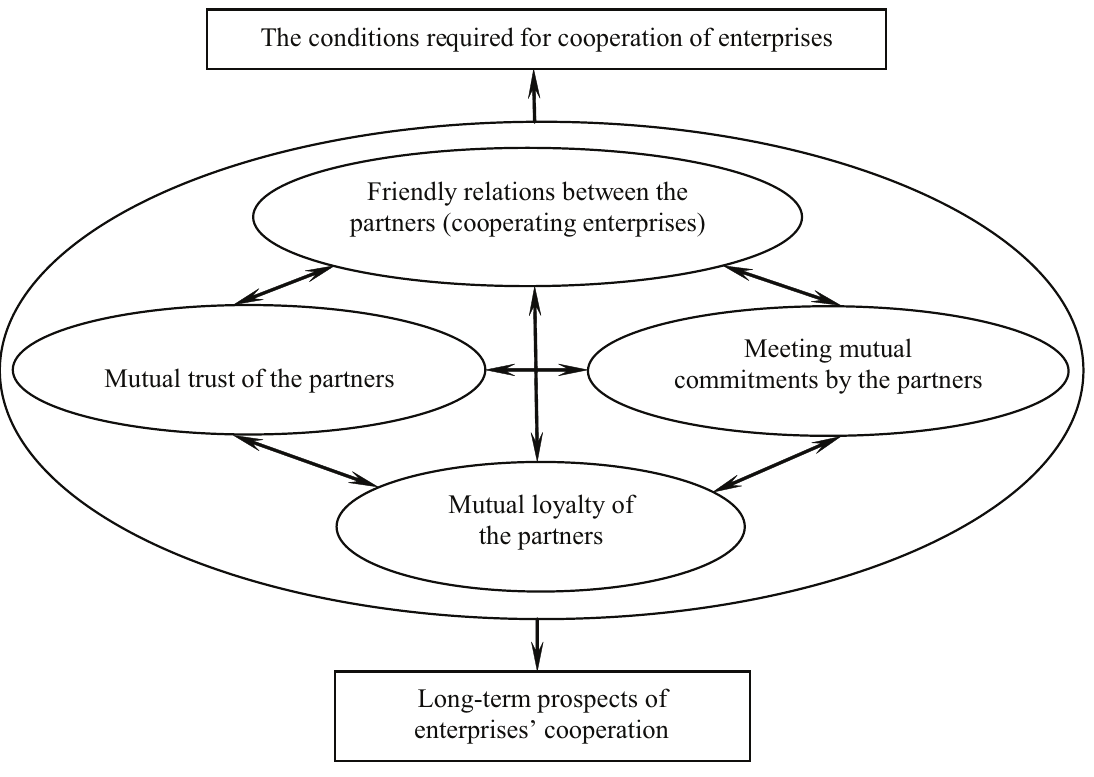
Fig. 2. A model reflecting the approach to cooperation by the followers of social exchange